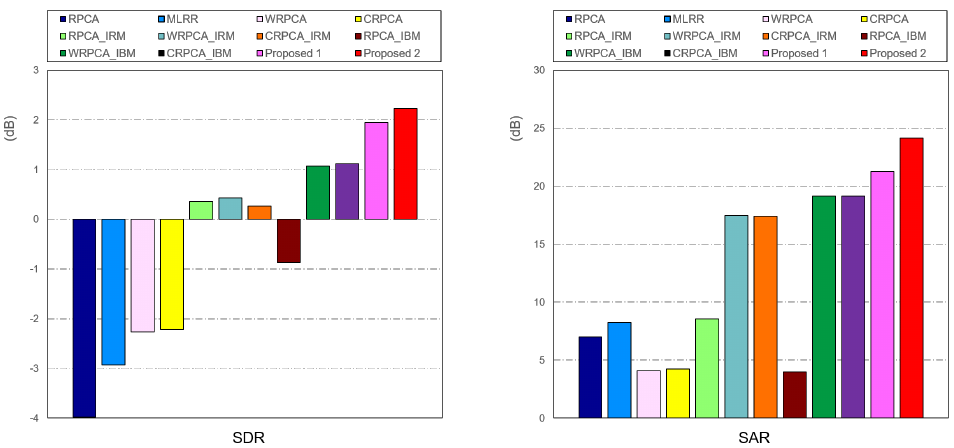
Figure 7. Comparison of SVS on DSD100 dataset for each of the following: RPCA, MLRR, WRPCA, CRPCA, RPCA using IRM, WRPCA using IRM, WRPCA using IRM, RPCA using IBM, WRPCA using IBM, CRPCA using IBM, Proposed 1, and Proposed 2, respectively.